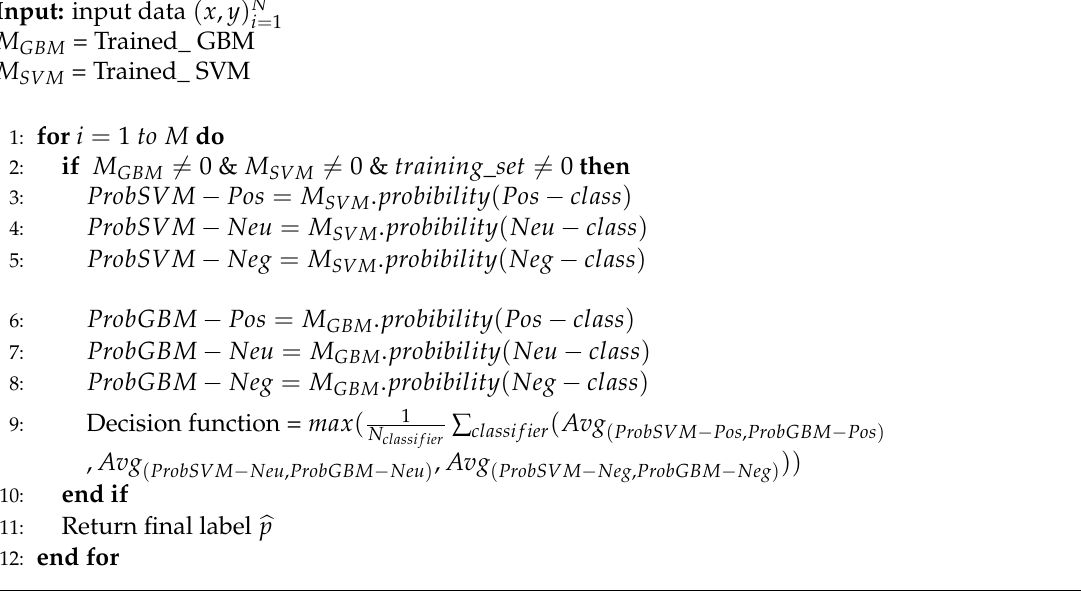
Algorithm 3 Gradient Boosted Support Vector Machine